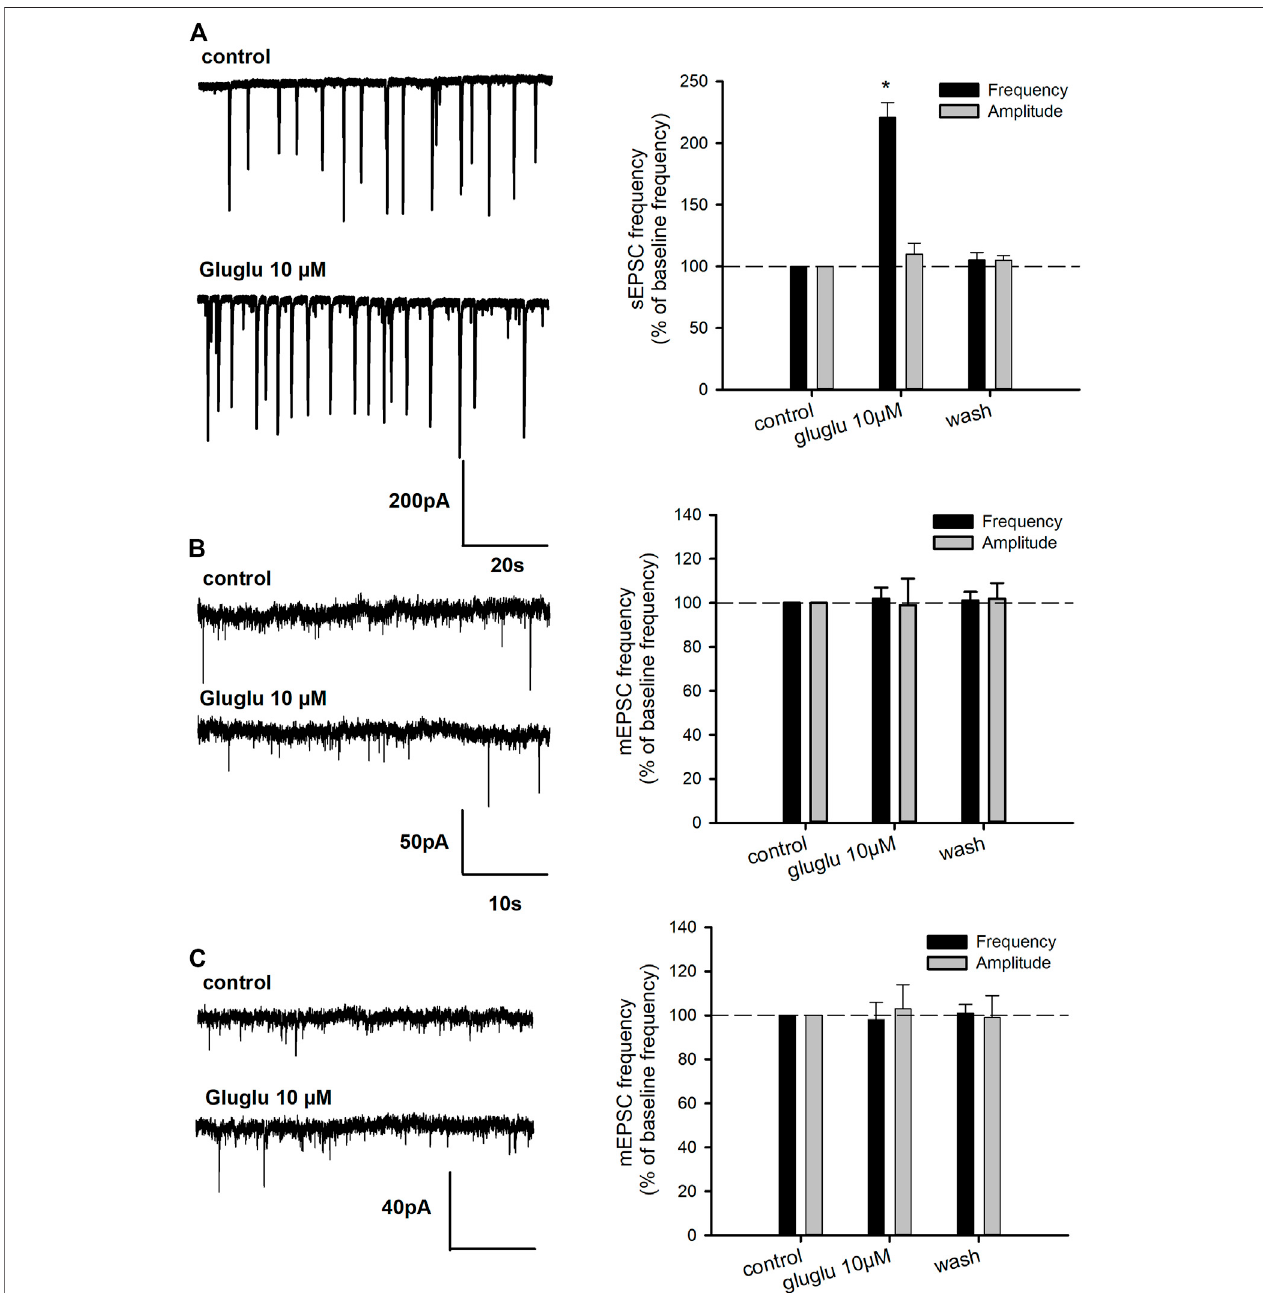
FIGURE 2 | Effect of γ -Glu-Glu on spontaneous excitatory synaptic transmission. (A) On the left, representative traces showing the exciting effect of γ -Glu-Glu on sEPSC recorded in the Mg 2+ -free medium. A recapitulative graph plotting the changes in sEPSC frequency and amplitude is shown. Data are expressed as averages ( ± SEM)ofsEPSC frequenciesoramplitudes, normalizedtorespectivebasalsEPSCfrequencyoramplitude.* p < 0.05 vs. baseline frequency(one-way ANOVAfollowed by the Holm – Sidak t-test) (B) Miniature spontaneous transmission (mEPSC) was recorded in the presence of TTX (500 nM) in a Mg 2+ ion – containing extracellular medium. Onthe left, theextracts ofmEPSC recordingsobtained inthe control and inthe presence of γ -Glu-Glu areshown. On theright, a graphplot mEPSC frequency and amplitude. Data are expressed as averages ( ± SEM) of mEPSC frequencies or amplitudes normalized to the respective basal mEPSC frequency or amplitude. (C) Miniature EPSCs wererecordedin thepresence ofTTX(500 nM) inaMg 2+ ion – freemedium. Onthe right, agraph plotmEPSC frequency and amplitude isshown. Data are expressed as averages ( ± SEM) of mEPSC frequencies or amplitudes normalized to the respective basal sEPSC frequency or amplitude.